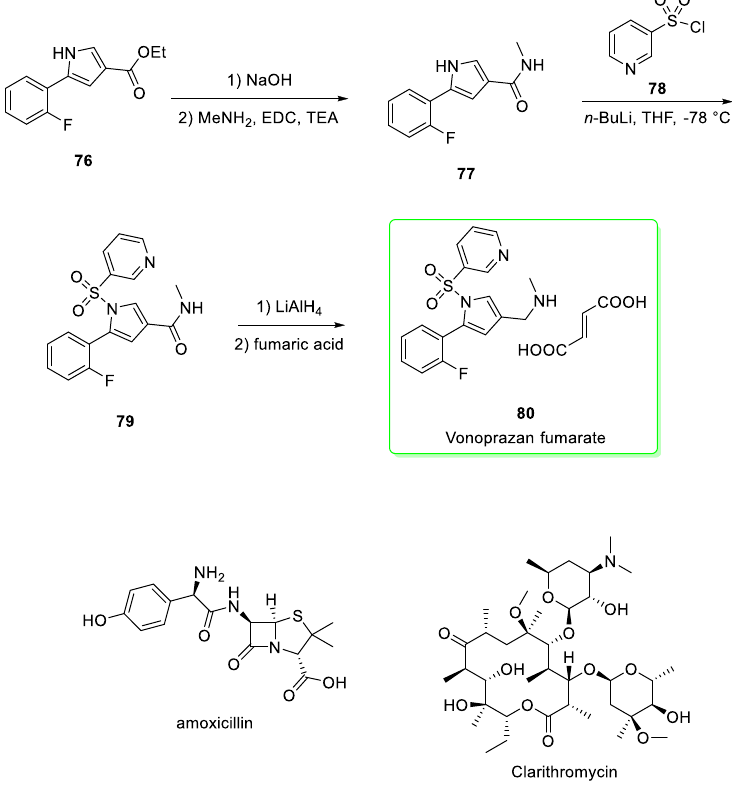
Scheme 9. Synthesis of vonoprazan fumarate ( 80 ) [32]. The structure of amoxicillin and